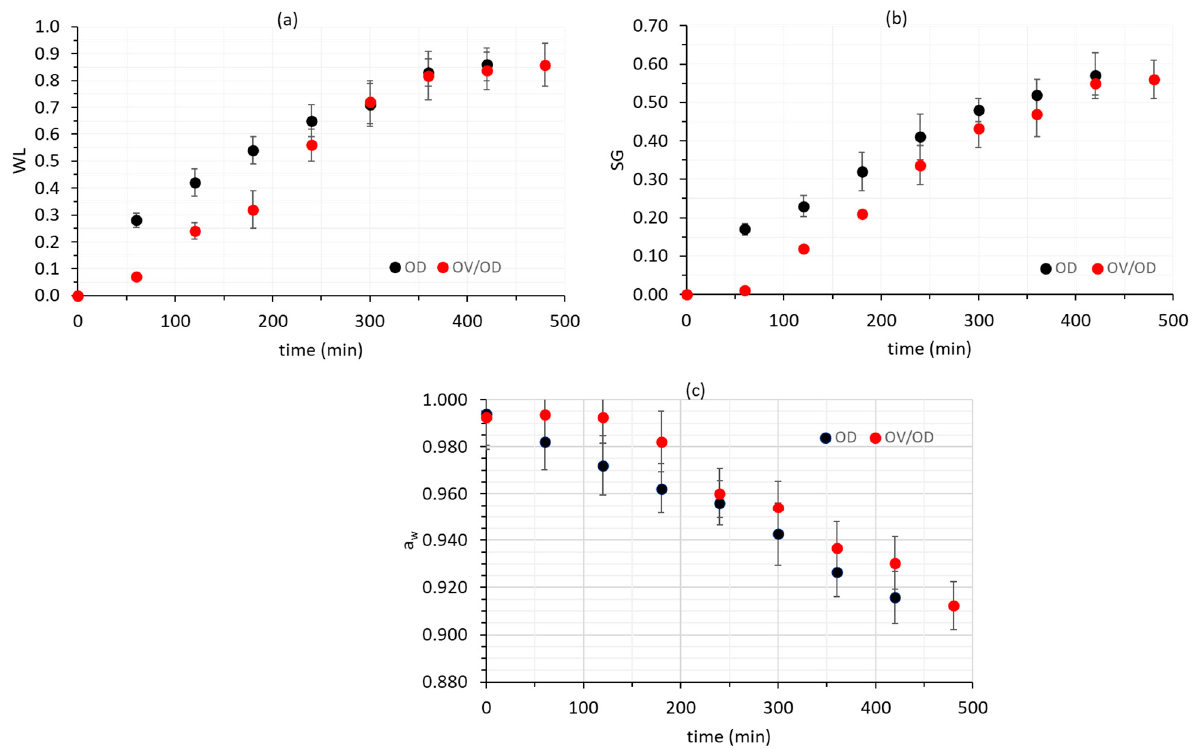
Figure 2. ( a ) Water loss (WL), ( b ) solid gain (SG) and ( c ) a w decrease of chicken fillets samples after OD and OV/OD at 40% glycerol concentration of the osmotic solution. Error bars represent the ±standard deviation of multiple measurements.